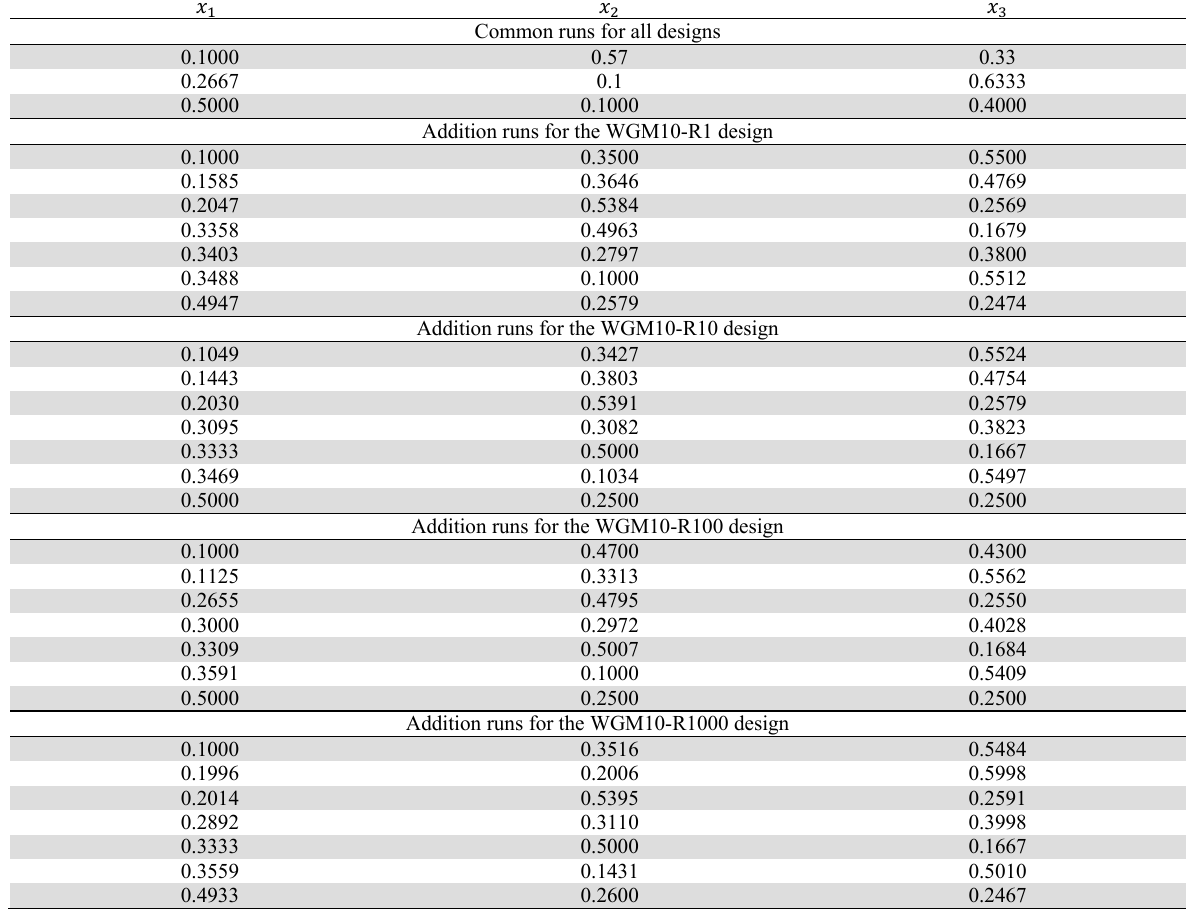
The WGM10 designs for Snee’s